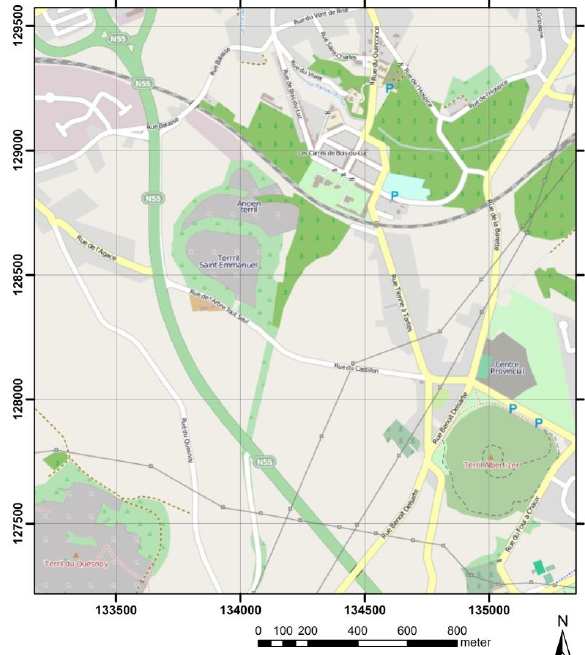
Figure 1: Topographic map of the Bois-du-Luc and its environment (source: OSM, grid in Belgian Lambert 72)